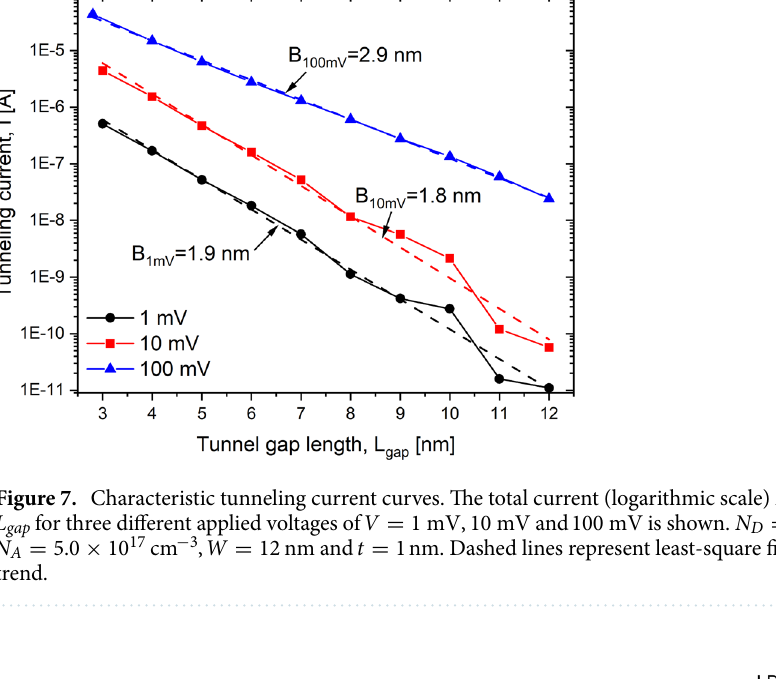
1 mV, 10 mV and 100 mV is shown. N =